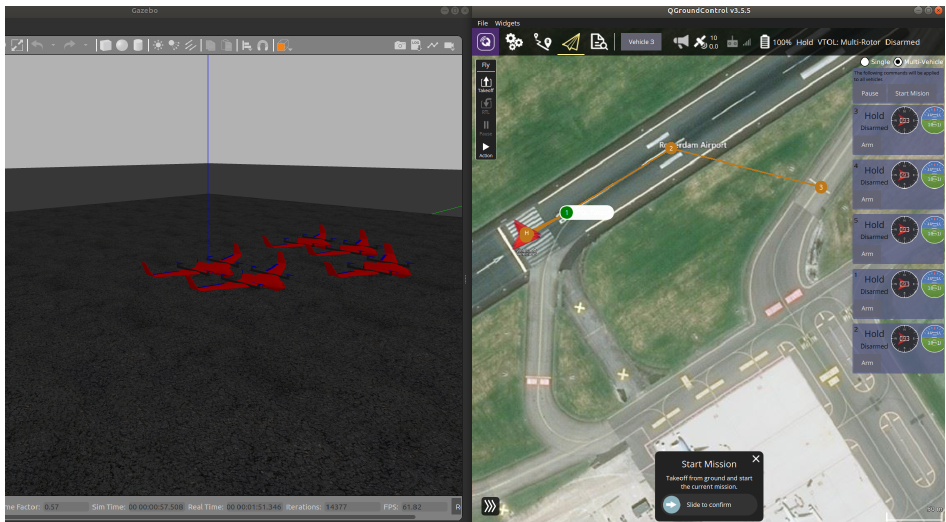
Figure 4. Launching five UAVs.